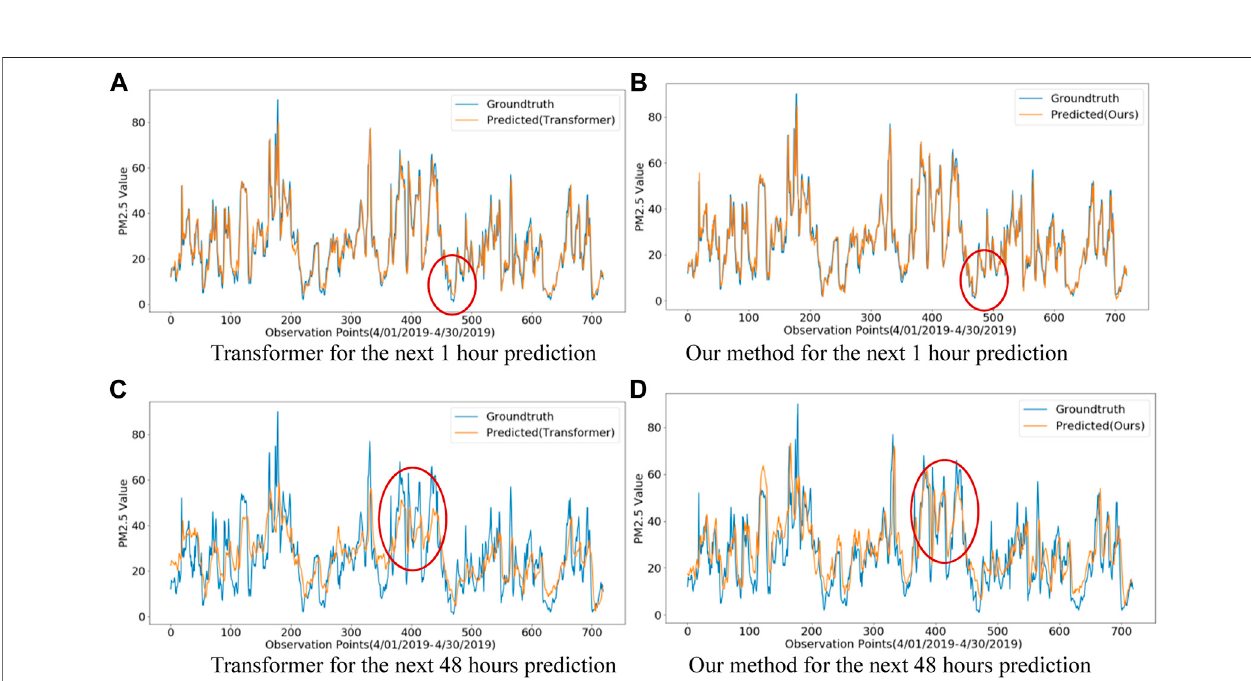
FIGURE15| Comparisonsofourmethodand Transformer onsingle-step (h1)and multi-step (h48)groundtruthandairquality prediction tasksduring 1 month (4/ 01/2019-4/30/2019) on Taizhou dataset.